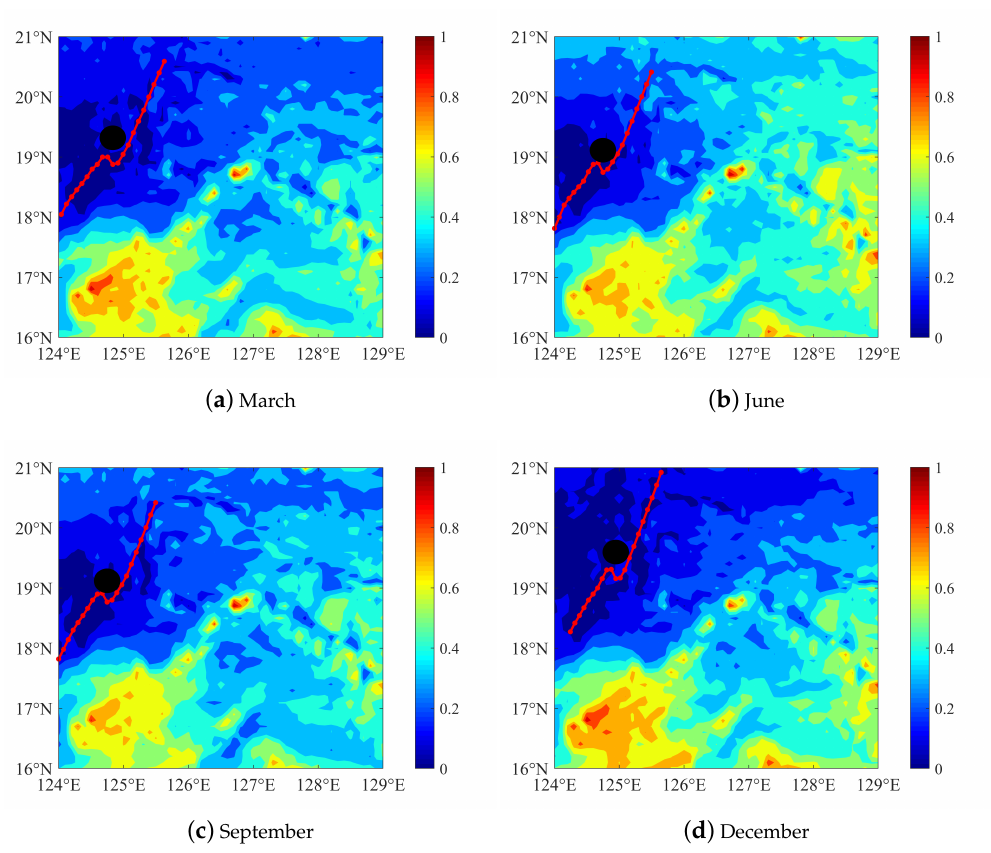
Figure 9. Obstacle avoidance based on the third